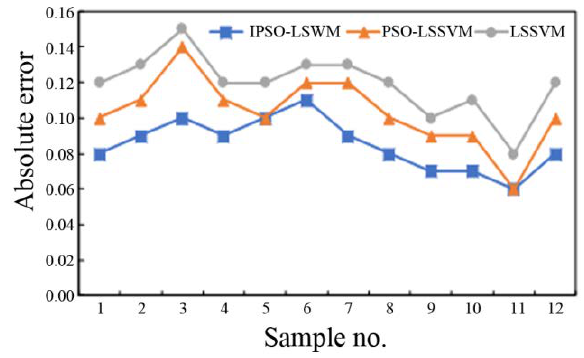
Figure 8. Absolute error results of different